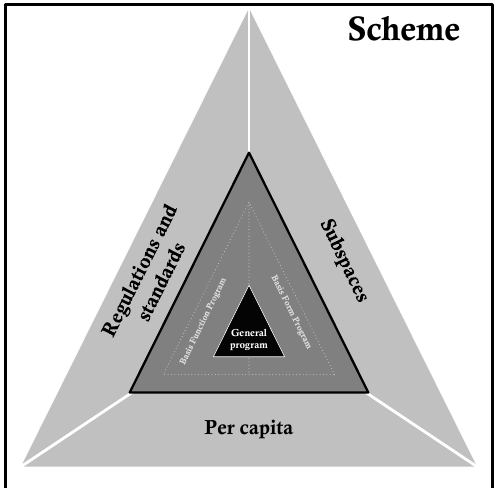
Figure 3 Cognitive studies (formulation of general program)